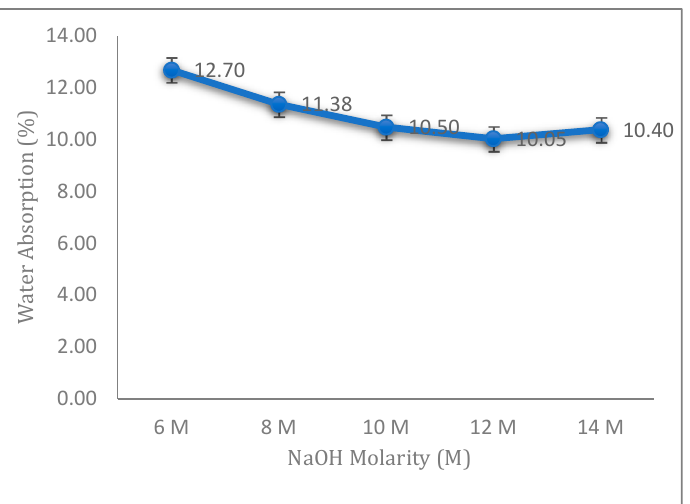
Figure 6. Water absorption of the fly ash geopolymer aggregate with different molarities of NaOH.